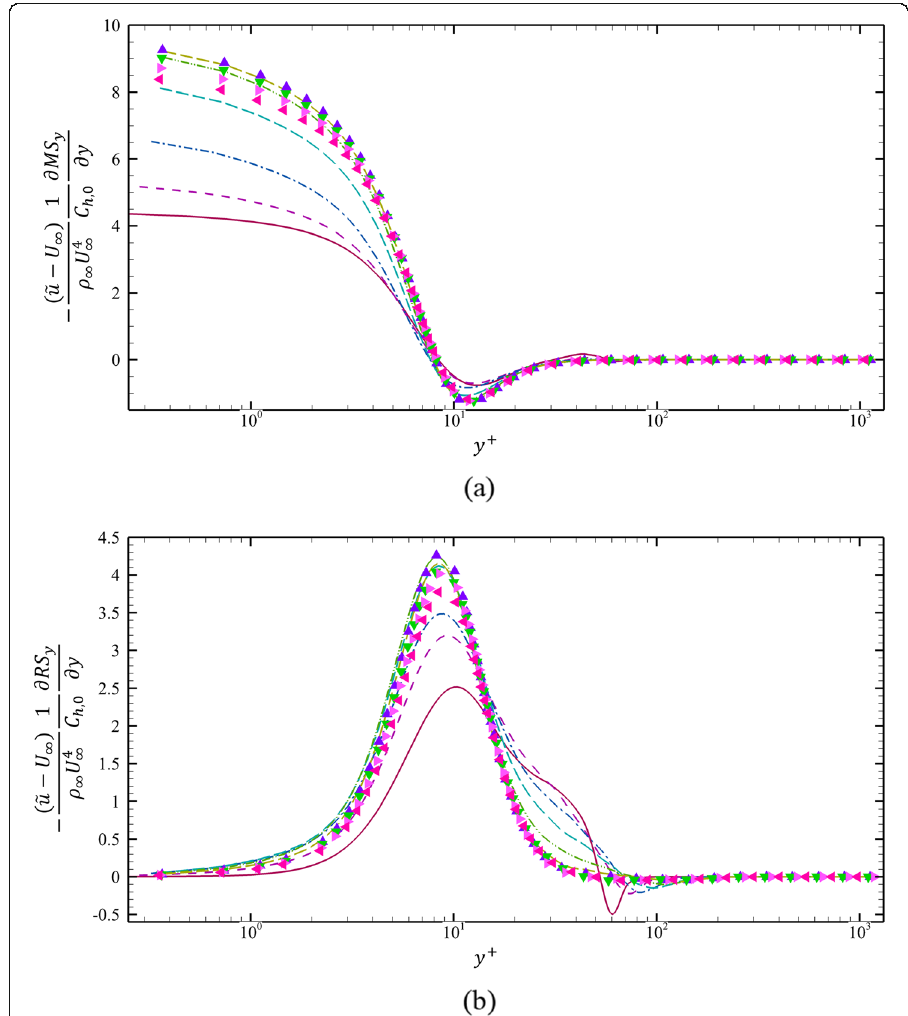
Fig. 7 The distribution of the integrand of the contribution of work done by ( a ) molecular stresses C h ,5 and ( b ) Reynolds stresses C h